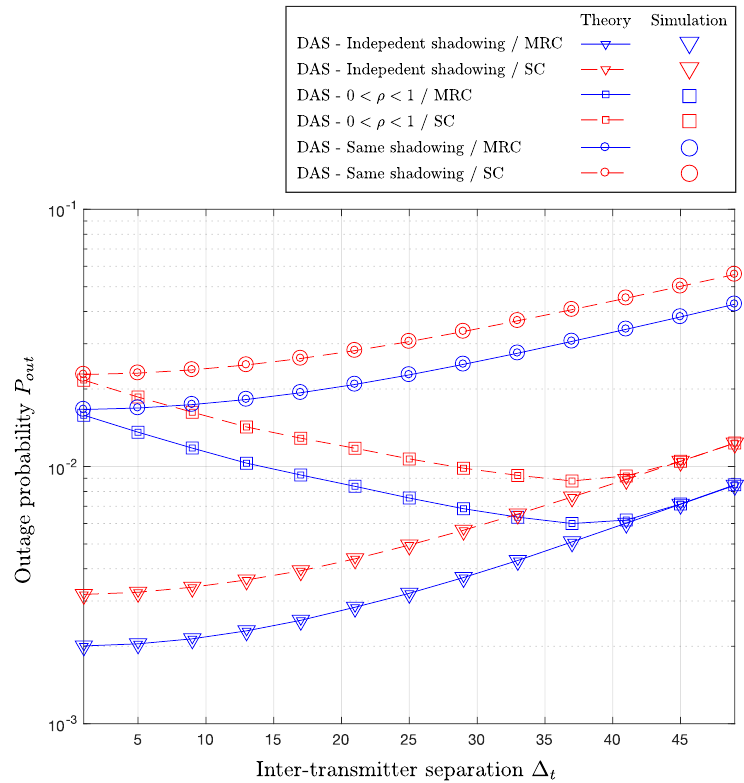
Figure 4. Outage probability P out versus inter-separation between the transmitters ∆ t , when γ th = 10 − 3 , l = 30 m, P T = 50 dB, n = 4, and σ = 8